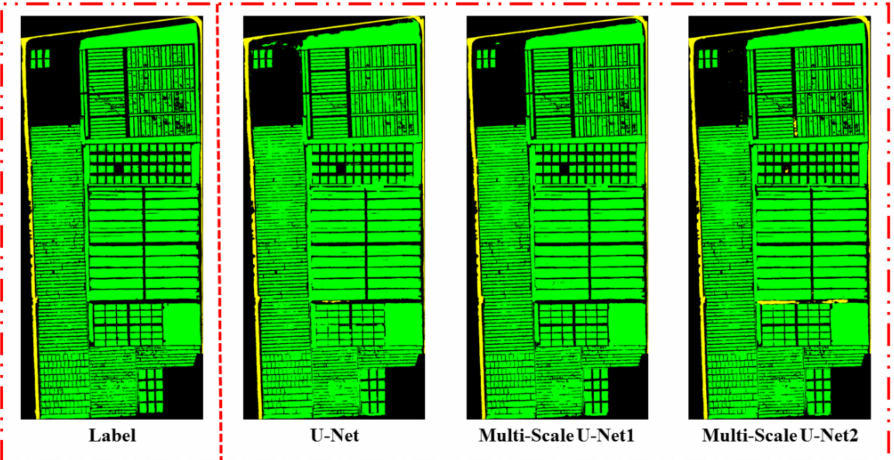
Figure 18. Three network models predict the results (GSD: 5.14 cm × 5.14 cm).